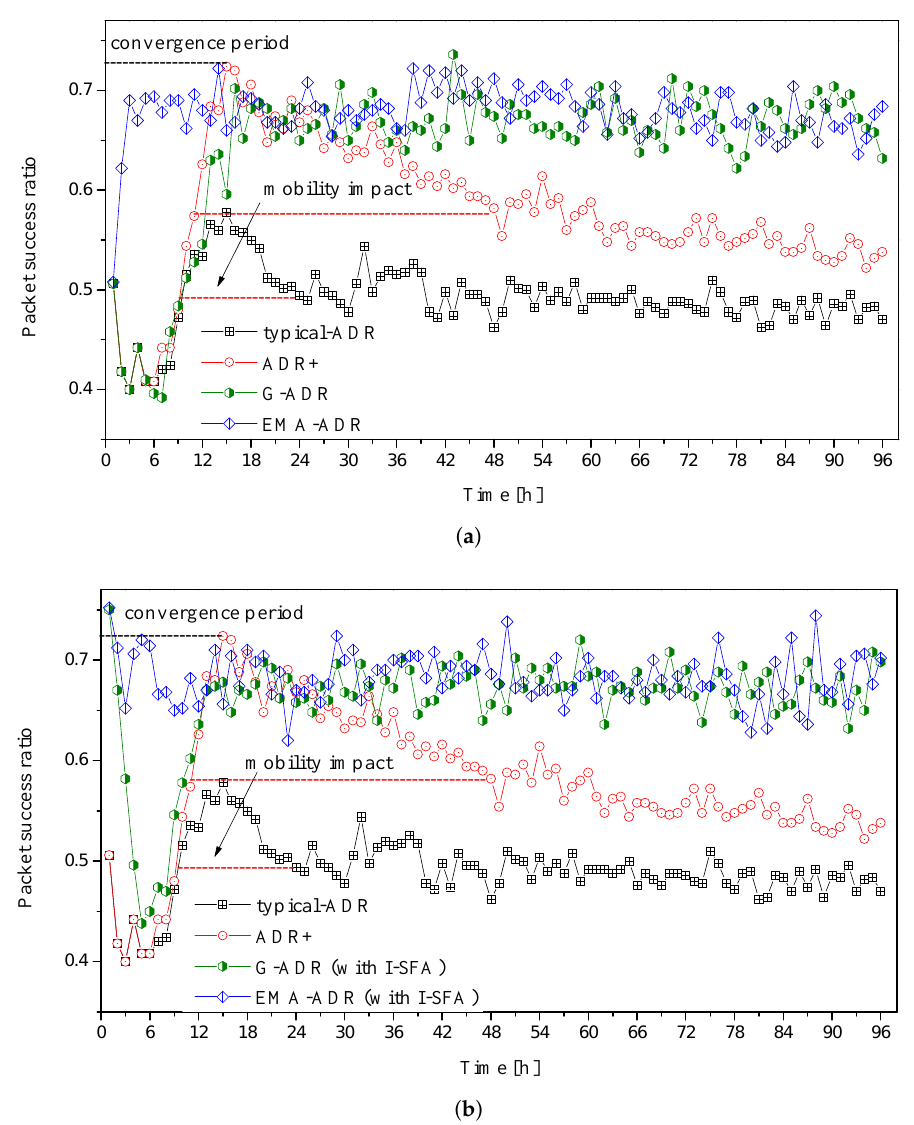
Figure 9. Convergence period and PSR of mobile EDs with N = 500: ( a ) initial allocation of SF = 12, and ( b ) initial allocation of SF = 12 (for ADR and ADR+) and initial SF allocation with I-SFA (for G-ADR and